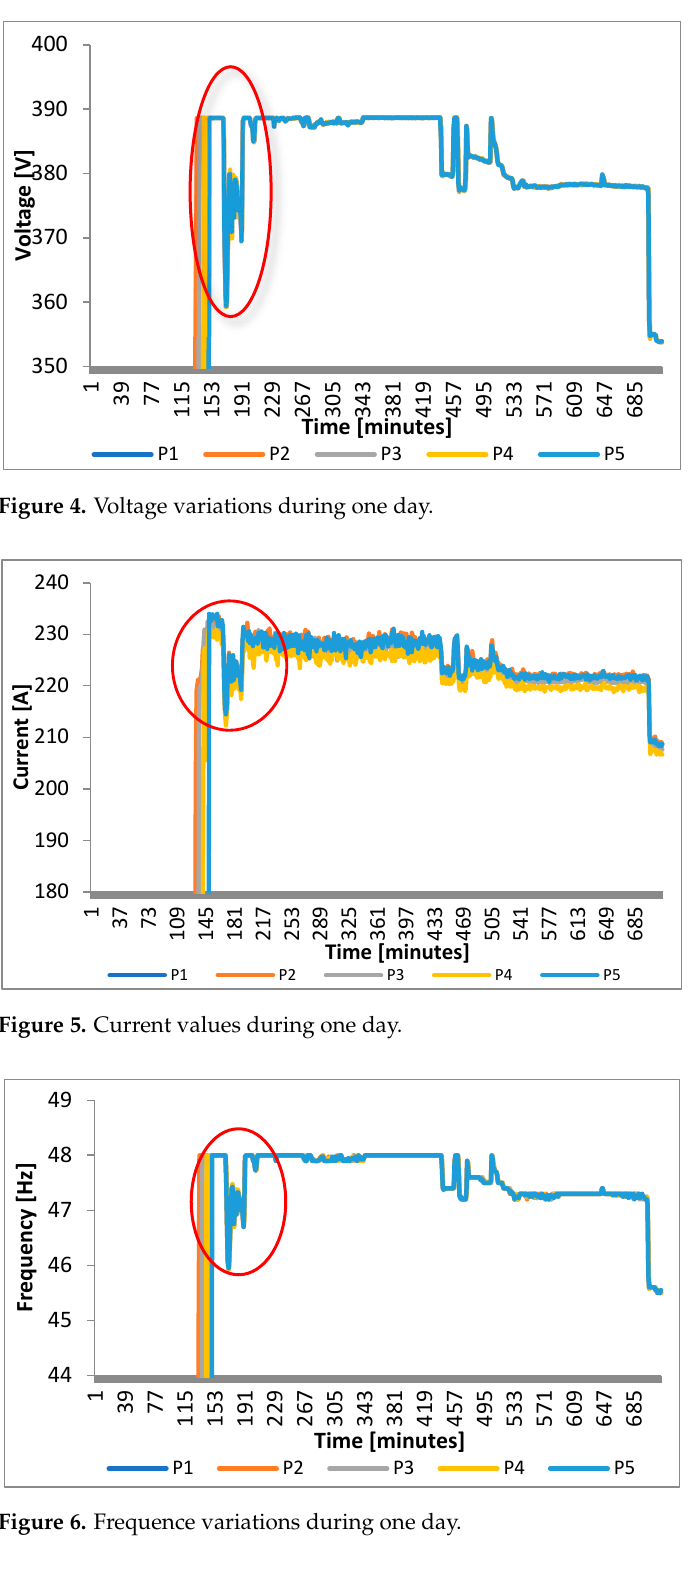
Figure 7. Flow values during one day. Using the data included in the input data matrix, and the parameter for the equiva- lent pump, the graphical representation of the characteristics F = f ( D i ), F = f ( P i ), F = f ( E Pe,n ), F = f ( C_p i,n ), for each hydraulic operating mode, was achieved in the following subsections. 3.1. Case 1. Hydraulic Operating Mode with 2 Pumps in Operation In Figures 8, 9, 10 and 11 the characteristics F = f ( D i ), F = f ( P i ), F = f ( E Pe,n ) and F = f ( C_p i,n ) for the case with two pumps in operation are represented. In this case, the pumps in op- eration are P1 and P2. From the F = f ( D i ) and F = f ( P i ) characteristics in Figures 8 and 9, two frequency bands of operation can be observed [44–45.5] and [47–48.5], in addition to some sparse values that were excluded in the maximum efficiency point determination. The best degrees of efficiency and the minimal pumping costs are registered in a frequency band [44–45.5], Figures 10 and 11.